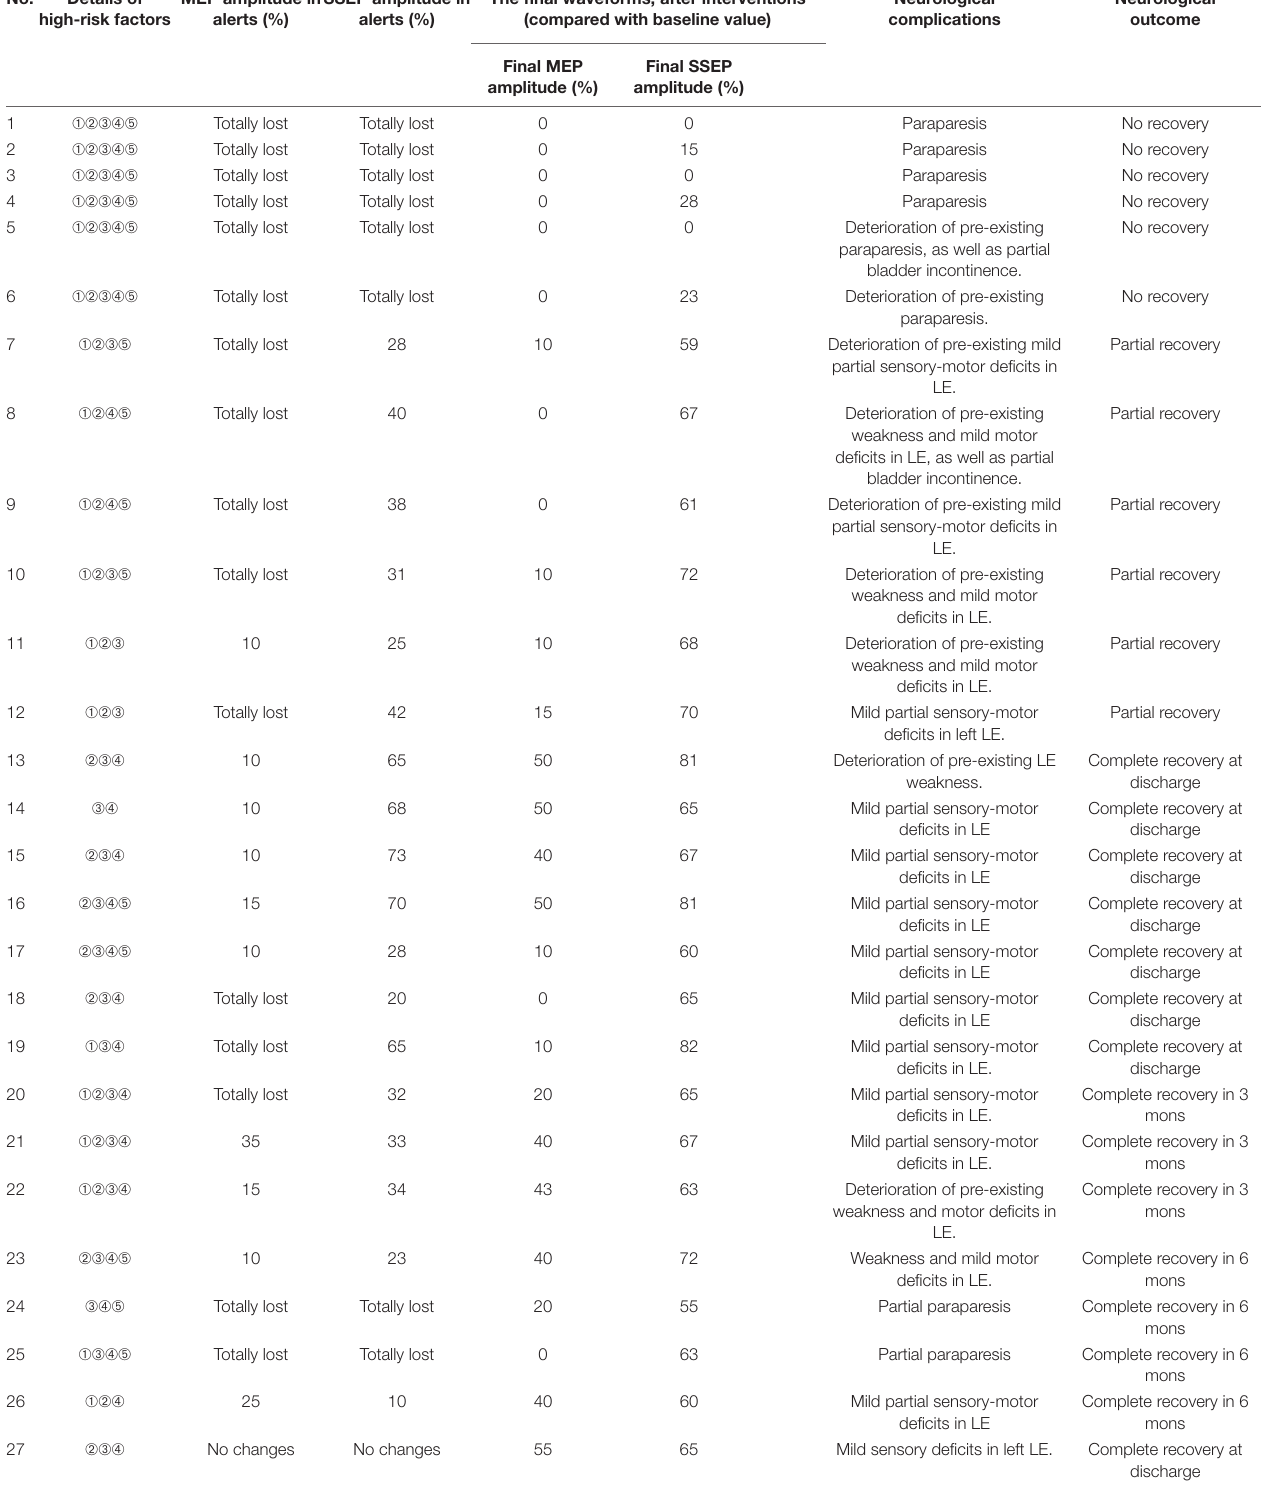
TABLE 5 | Details of patients developed into postoperative neurological deficits after posterior decompression for thoracic spinal stenosis. No. Details of MEP amplitude in SSEP amplitude in high-risk factors alerts (%) alerts